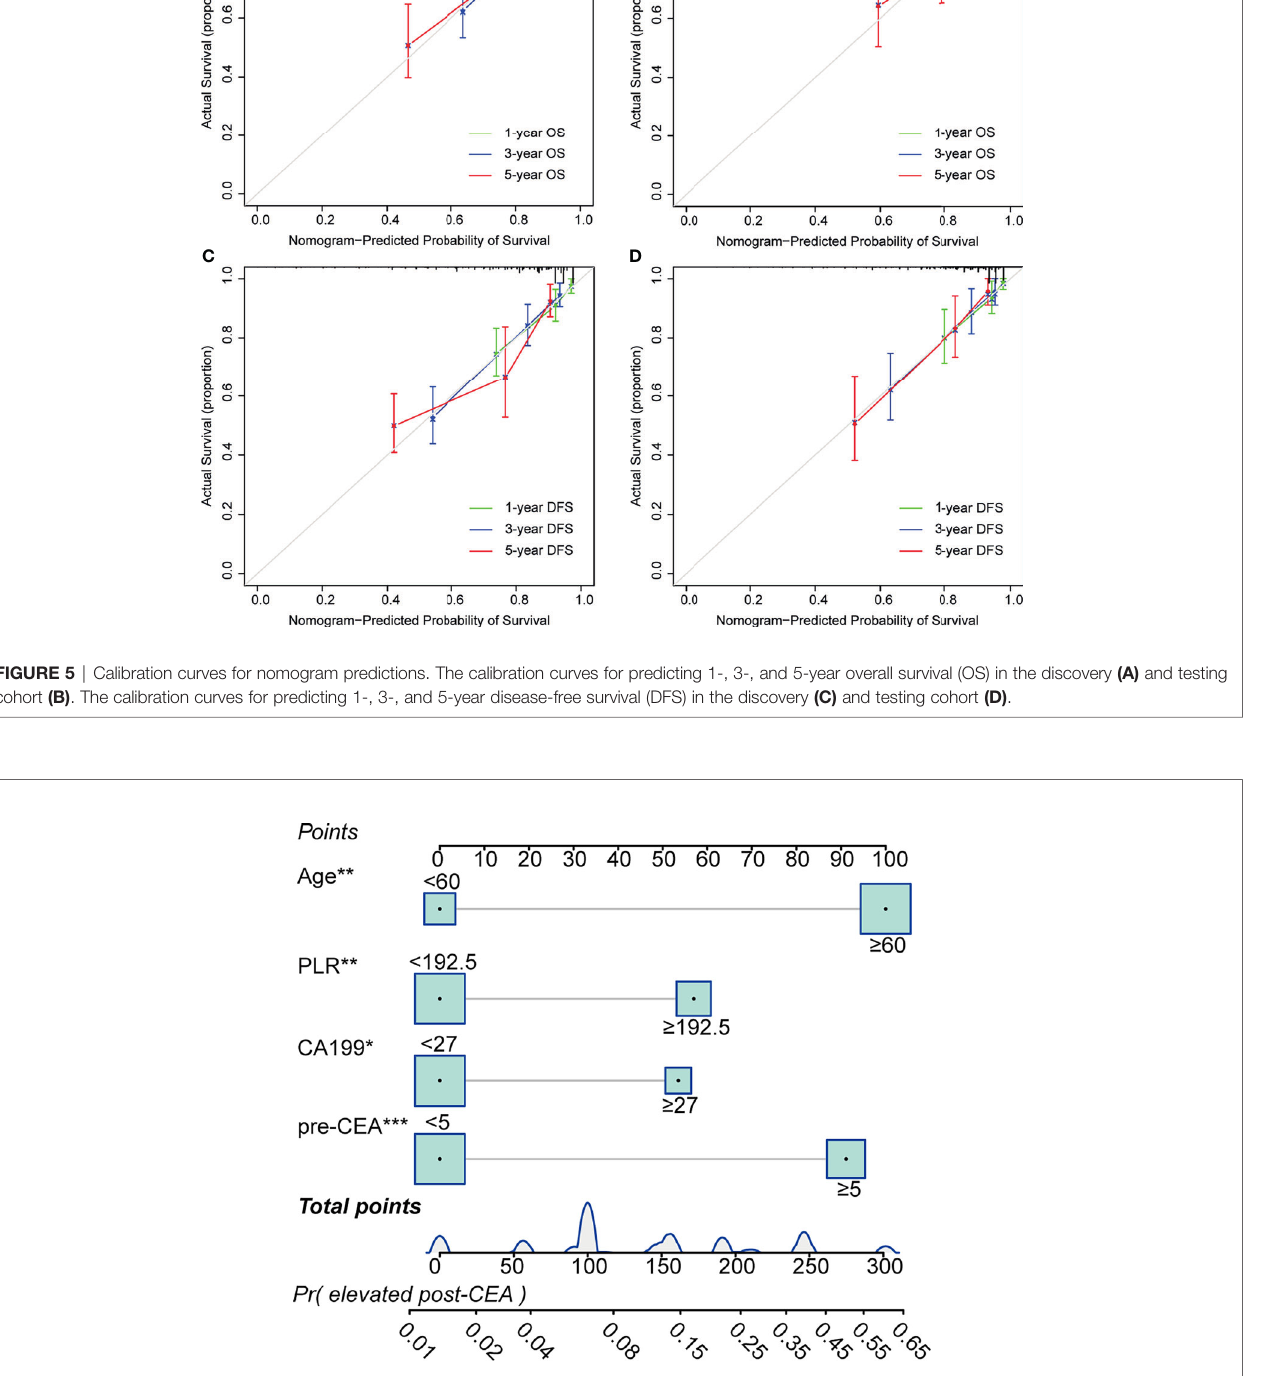
FIGURE 6 | Predictive model for predicting postoperative carcinoembryonic antigen (post-CEA) elevation in patients with colorectal cancer (CRC). PLR, platelet-to- lymphocyte ratio; pre-CEA, preoperative carcinoembryonic antigen; Pr, probability